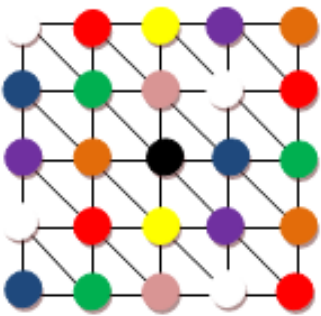
Figure 2. A 5 × 5 cellular graph tilled using the L(2,1) coloring.